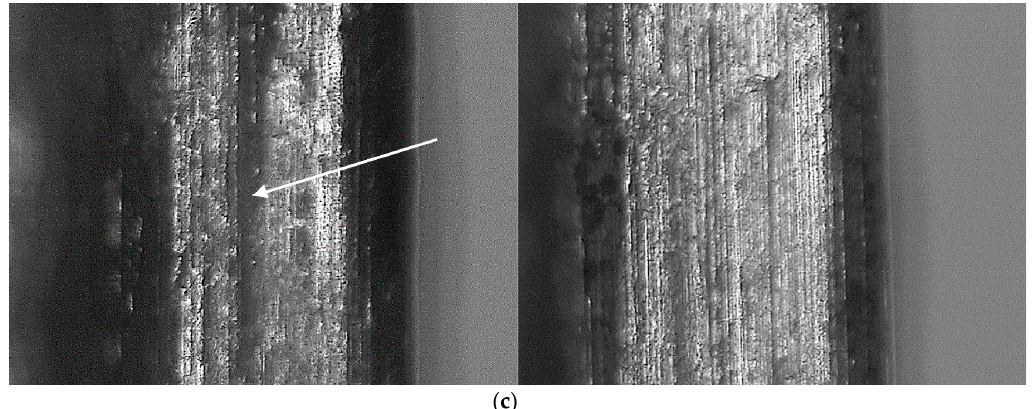
Figure 8. The pictures showing the lateral surfaces of NPSGs, left side, and PSGs, right side, acquired using an optical microscope. PSGs: ( a ) T: 550 °C, holding time: 10 min, punch pressure: 150 MPa, percentage force reduction: − 66%; ( b ) T: 550 °C, holding time: 15 min, punch pressure: 150 MPa, percentage force reduction: − 64%; and ( c ) T: 550 °C, holding time: 15 min, punch pressure: 150 MPa, percentage force reduction: − 30%. Regardless of the sintering process parameters, NPSGs show on their surfaces the consequences of the larger ejections.